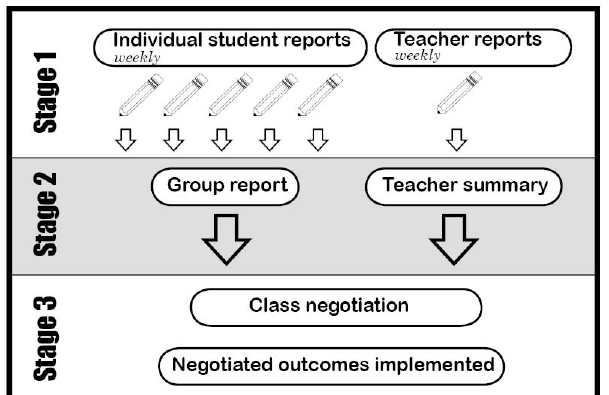
Fig. 1. Overview of IGCRA technique, using individual and group